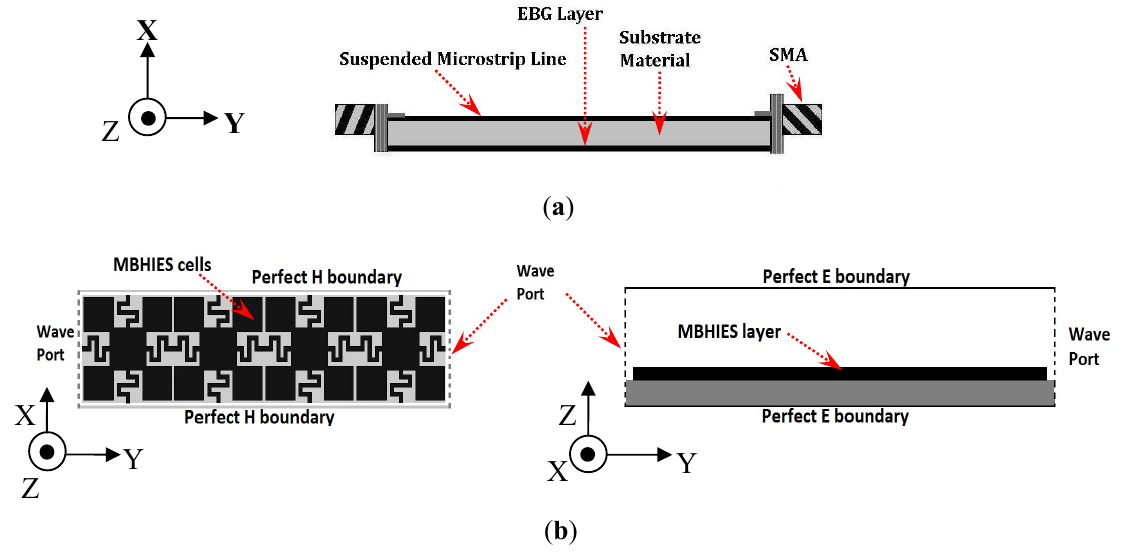
Figure 2. Bandgap prediction by ( a ) Suspended transmission line method; ( b ) Waveguide transmission